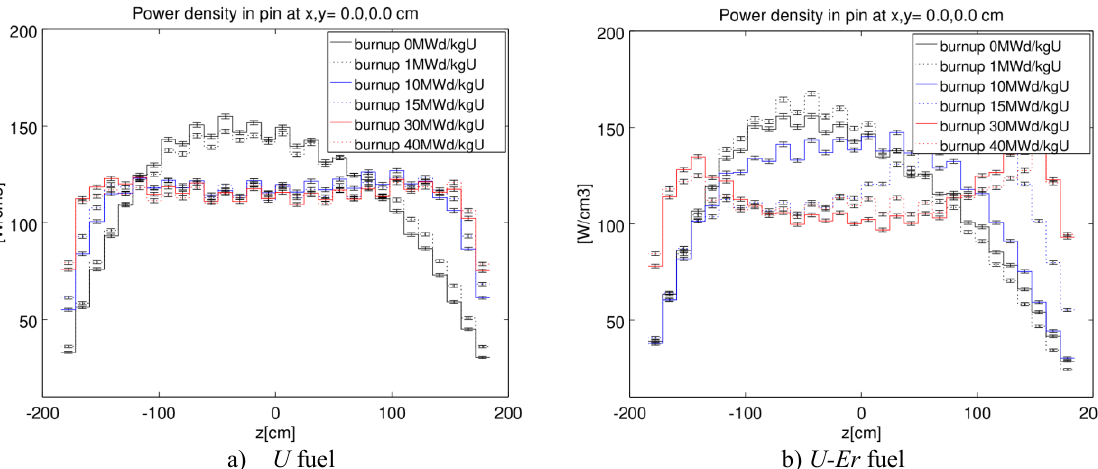
Figure 5 Evolution of axial power profiles with burnup for selected pins in both